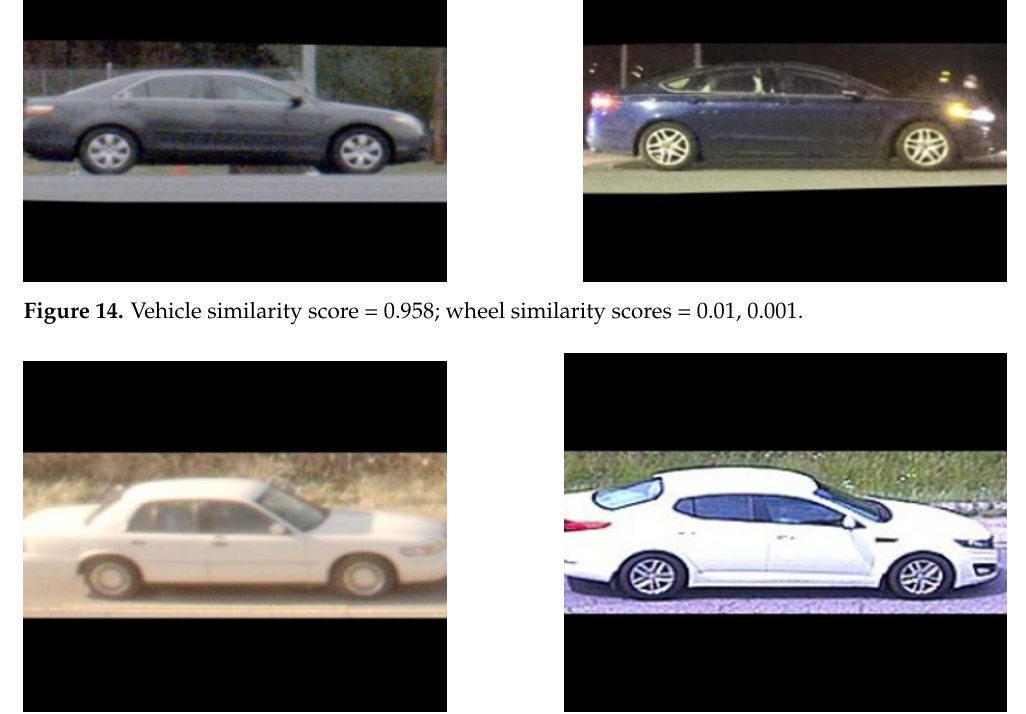
Figure 15. Vehicle similarity score = 0.64; wheel similarity scores = 0.02,